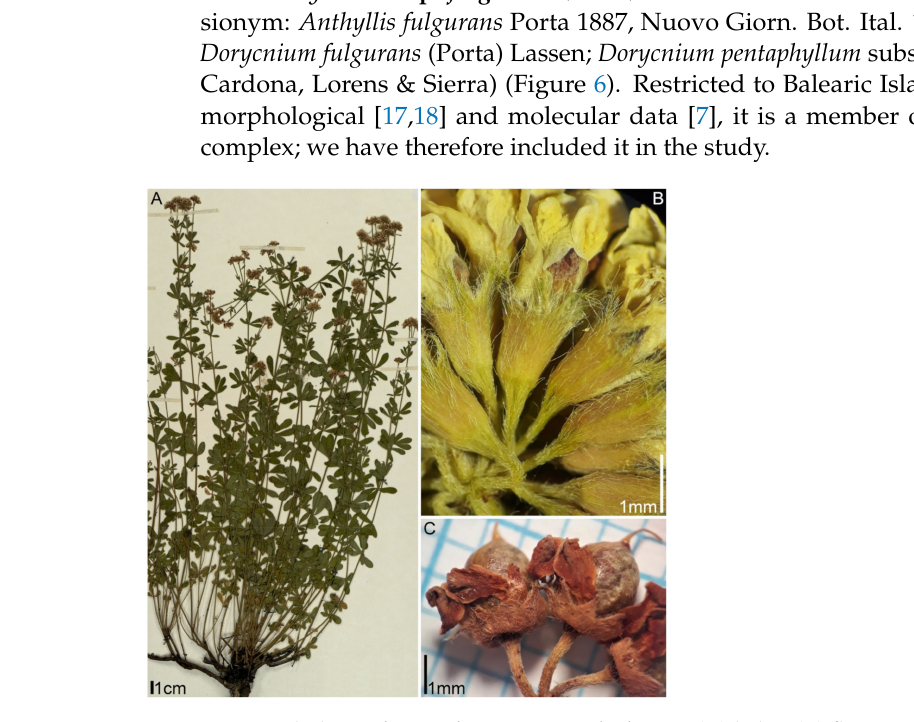
Figure 1. Morphology of Lotus dorycnium ssp. herbaceus : ( A ) habit; ( B ) flowers; ( C ) fruits. Herbarium specimens: ( A ) Crimea, D.D. Sokoloff s.n., MW0615046 (https://plant.depo.msu.ru/public/scan. jpg?pcode=MW0615046; accessed 16 January 2022); ( B ) Turkey, Tuzlacı 50735 (ISTE); ( C ) Turkey, S. Yüzba¸sio˘glu et al. 106380 (ISTE).